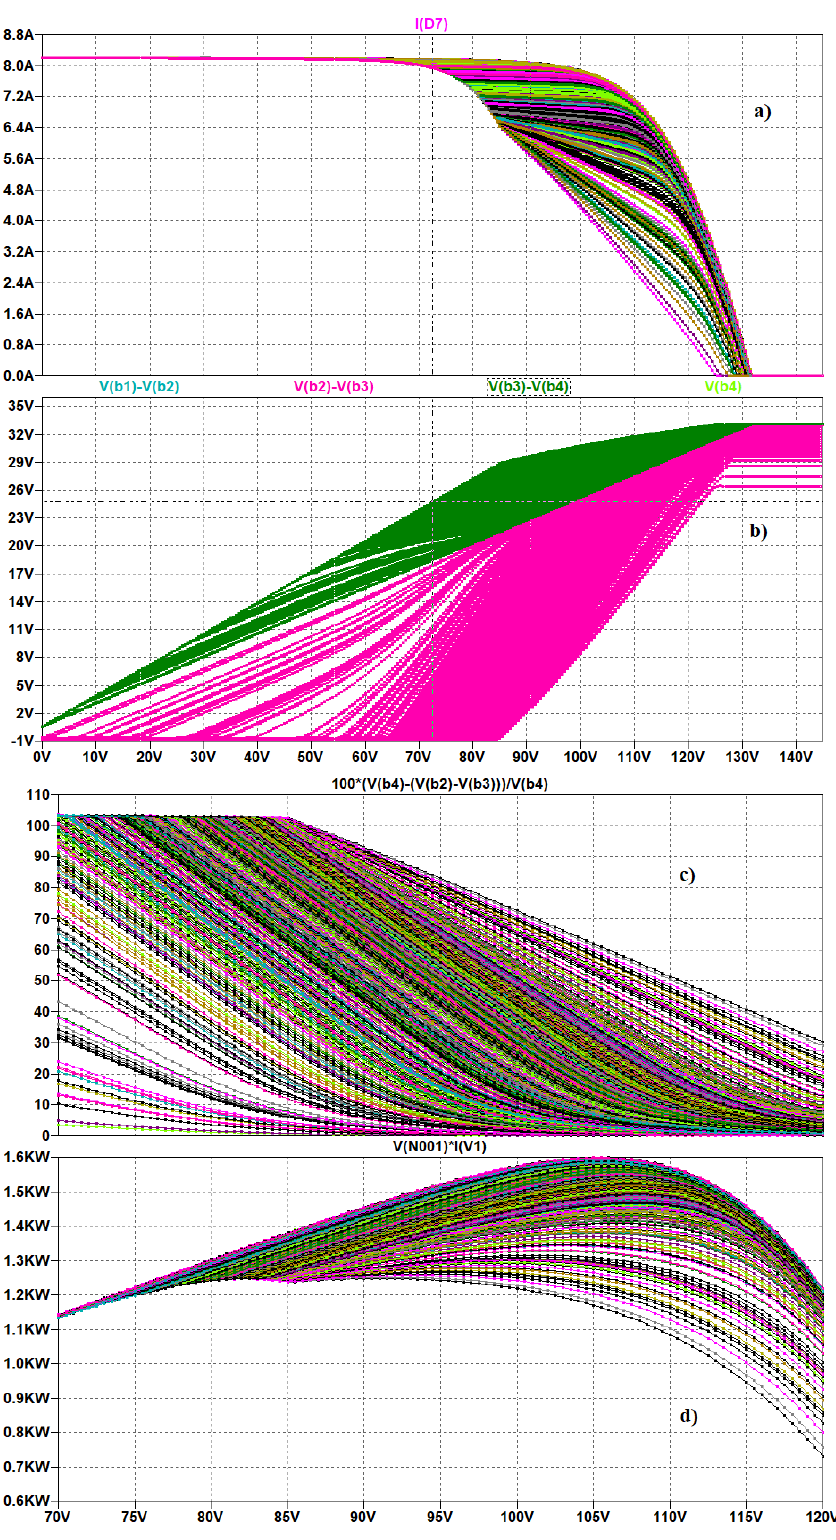
Figure A3. Potential induced degradation faults type 1. This figure shows four charts as following: ( a ) the current of the affected string versus the operation voltage of the array, ( b ) the differential voltage for all the modules in the affected string, ( c ) the relative percentage difference versus the operating voltage of the array, ( d ) peak behavior of output power in the